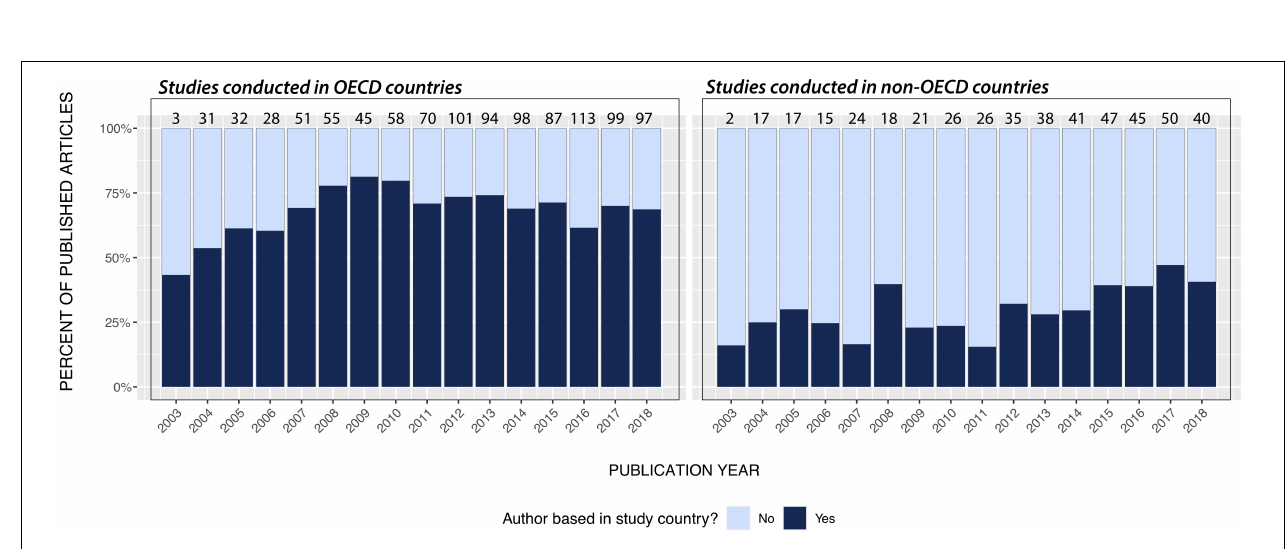
FIGURE 3 | Percentage contribution to published articles over time by authors affiliated in-country vs. out-of-country. (Excludes articles with a regional/global focus and those without a geographic focus), shown disaggregated by research conducted in nations that were OECD members (left panel) ( n = 1,062 articles) and non-OECD members (right panel) ( n = 462). Values along the top indicate the number of articles analyzed. Articles can appear in both panels if they were conducted in more than one nation.